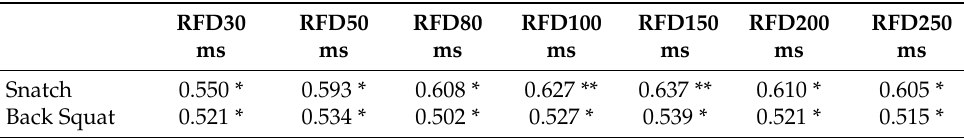
Table 3. Correlation coefficients between snatch and back squat with isometric leg press rate of force development ( n =